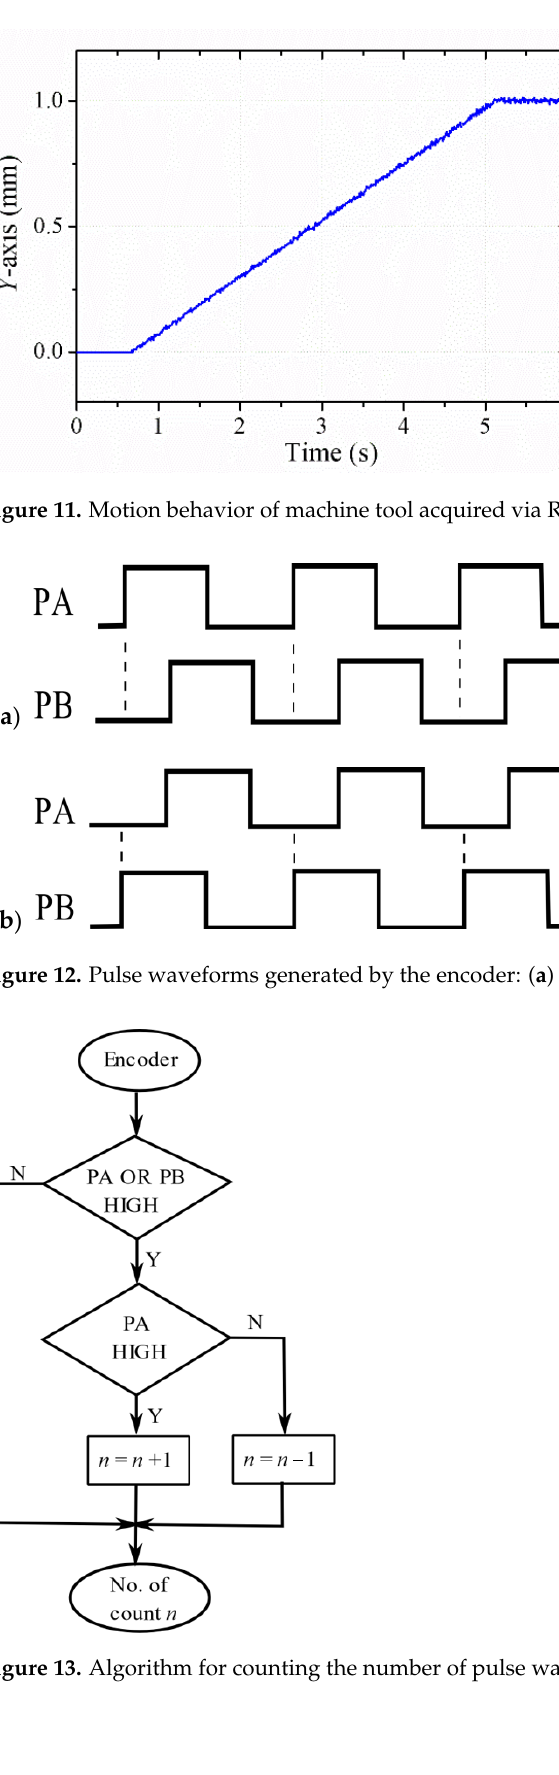
Figure 14. Motion behavior of machine tool acquired via Raspberry Pi. 4.6. Dashboard Implementation of Sensors Figure 15 shows the real-time data displays on the web page. All the sensor signals ac- quired from different locations can be simultaneously shown with the link to the application of Node-RED. This allows the user to observe the operational condition of the legacy machine and the on-site environment in real time. In addition, the acquired data stored in the database can be retrieved and displayed on the web page as shown in Figure 16, where historical data of vibration and sound are presented. On the web page, a filter is used to select a specific ac- quired information for observation. Moreover, a Web API interface is provided to retrieve the stored data such that the machining performance of the legacy machine relating to the opera- tional and environmental conditions can be precisely examined in a future study.